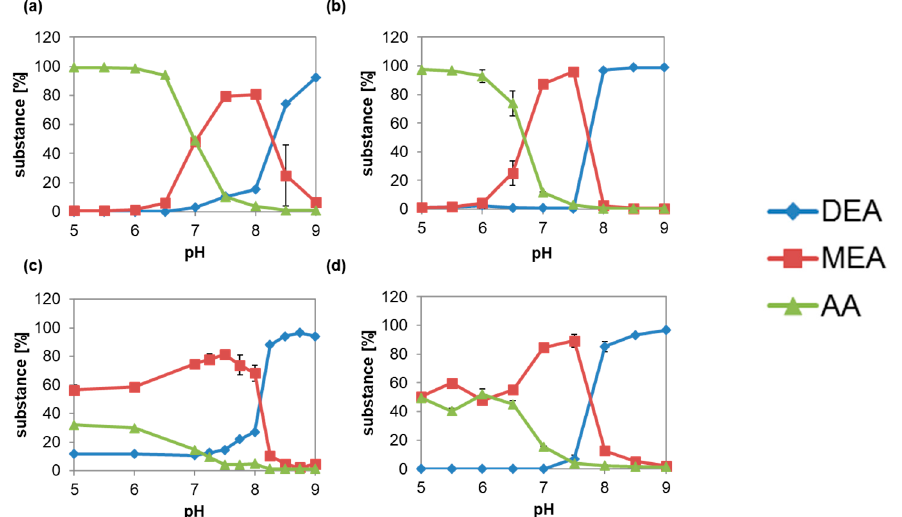
Figure 4. Minimization of AA formation in DEA hydrolysis catalyzed by ACut2-6hp adsorbed ( a , c ) or covalently bonded ( b , d ) in dependence of pH during immobilization ( a , b ) and pH during reac- tion ( c , d ). Immobilizates were loaded with 4 mg protein g − 1 carrier. Measurements were made in duplicate. Represented are the mean ± SD.